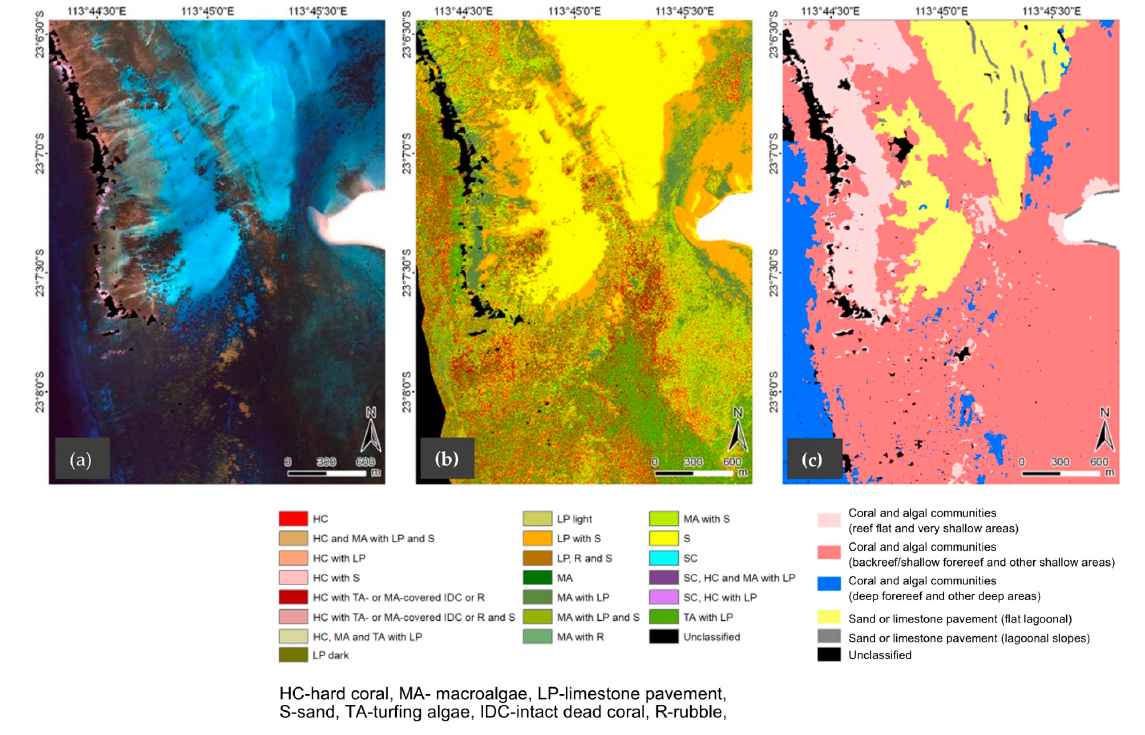
Figure 12. Point Maud area (north of Coral Bay) ( a ) subsurface reflectance, ( b ) pixel-based benthic habitat map, and ( c ) geomorphic classes.